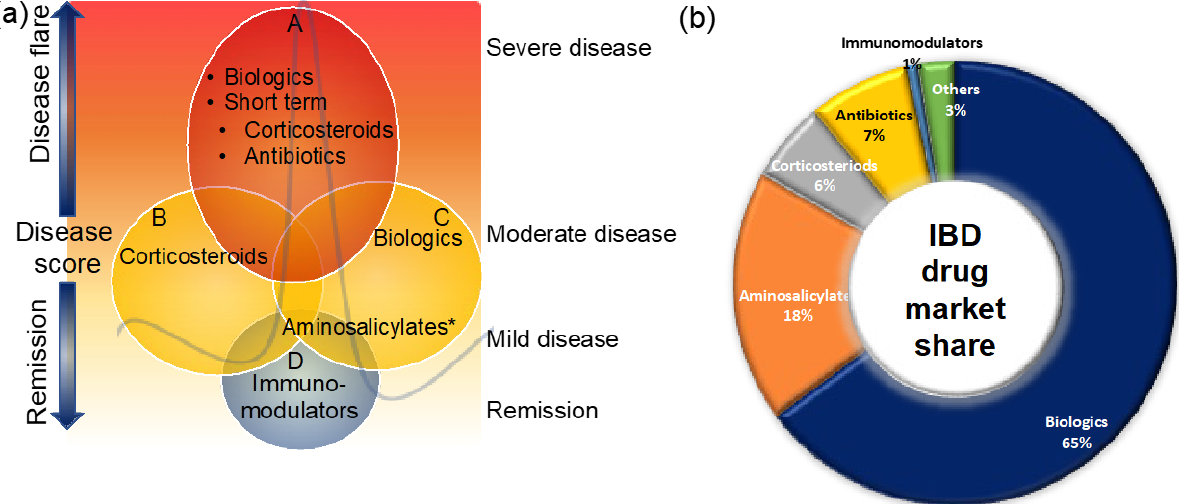
Figure 2. Clinical management of IBD patients during disease flare and remission ( a ) and the market